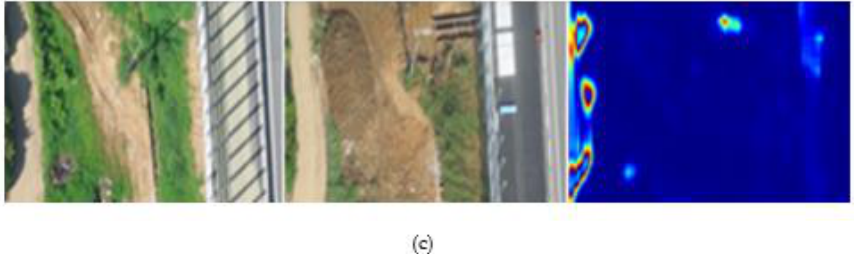
Figure 3. Cases of errors while detecting changes based on general change detection data: ( a ) Con- struction equipment, ( b ) automobile, ( c ) shadow. The left figures are time 1 images, the middle figures are time 2 images, and the right figures show the results obtained using change detection.